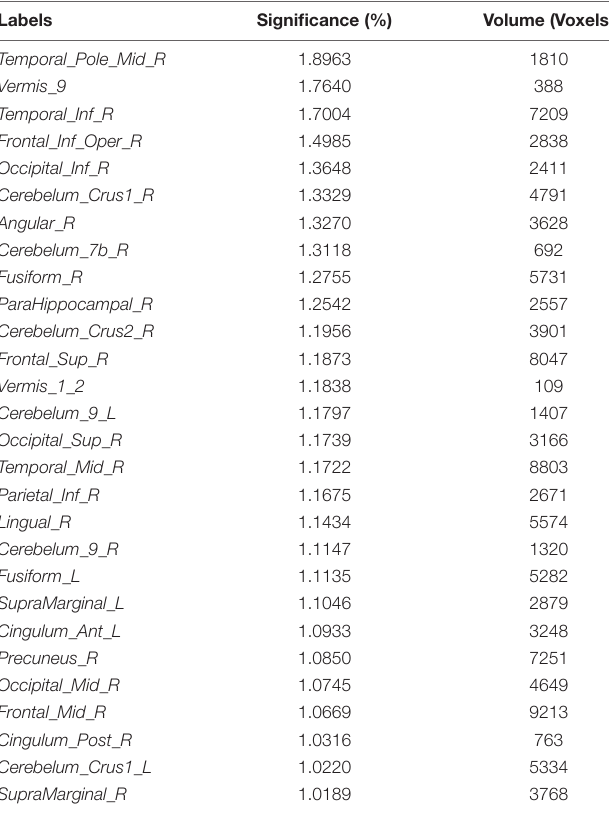
TABLE 4 | ROI weights and voxel sizes of the circuit predicting the Zanarini-Interpersonal sector for BPD.